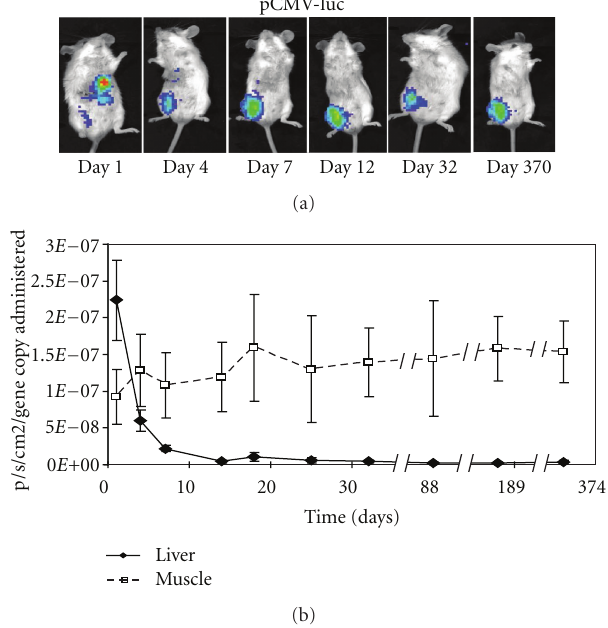
Figure 2: Duration of plasmid-based CMV promoter activity in vivo in liver and muscle. pCMV-luc was delivered to liver and thigh muscle ( n = 10) by electroporation and luminescence analysed in vivo over time using IVIS live whole body imaging. CMV activity in liver is initially high but reduced to background level by day 14. A gross reduction in expression over time was not apparent in